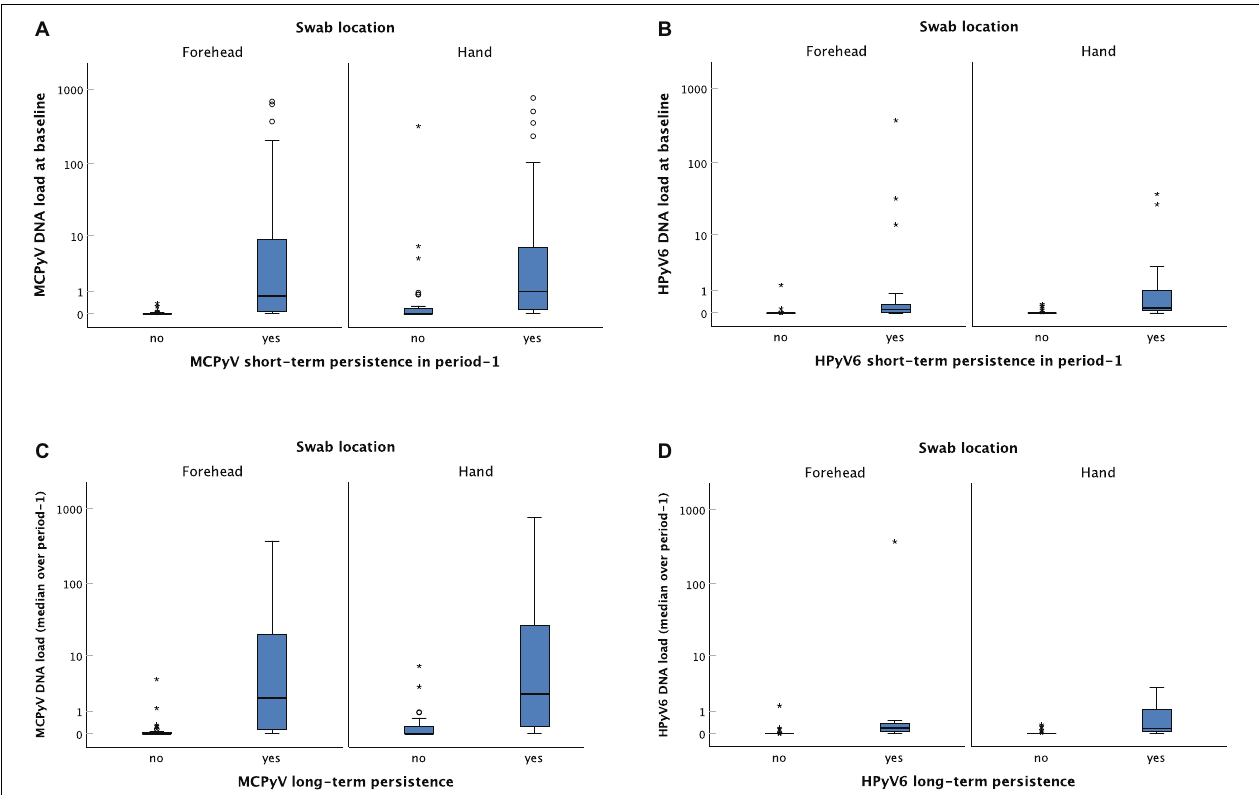
FIGURE 4 | Merkel cell polyomavirus (MCPyV) and HPyV6 DNA loads on the forehead and the hand of individuals without and with short-term (A,B) and long-term (C,D) persistence. Viral DNA loads (Y-axis) were expressed as viral DNA copies per betaglobin-gene copy. Boxes represent the interquartile range with the median. Whiskers are vertical lines ending in horizontal lines at the largest and smallest observed values that are not statistical outliers, i.e., values more than three IQRs from the end of a box are labelled as extreme, denoted with an asterisk (*) and values more than 1.5 IQRs but less than 3 IQRs from the end of the box are labelled as outliers (o). (A) MCPyV and (B) HPyV6 baseline viral DNA load distribution of individuals without (left box plot) and with (right box plot) short-term persistence in collection period-1. The differences in viral DNA loads between individuals without and with short-term persistence were significant for both locations and both viruses [ p < 0.001 for forehead ( n = 109) and hand ( n = 109), respectively; independent-samples Mann–Whitney U test]. (C) MCPyV and (D) HPyV6 median DNA loads over collection period-1 of individuals without (left box plot) and with (right box plot) long-term persistence. The differences in viral DNA loads between individuals without and with long-term persistence were significant for both locations and both viruses [ p < 0.001 for forehead ( n = 59) and hand ( n = 59), respectively; independent-samples Mann–Whitney U